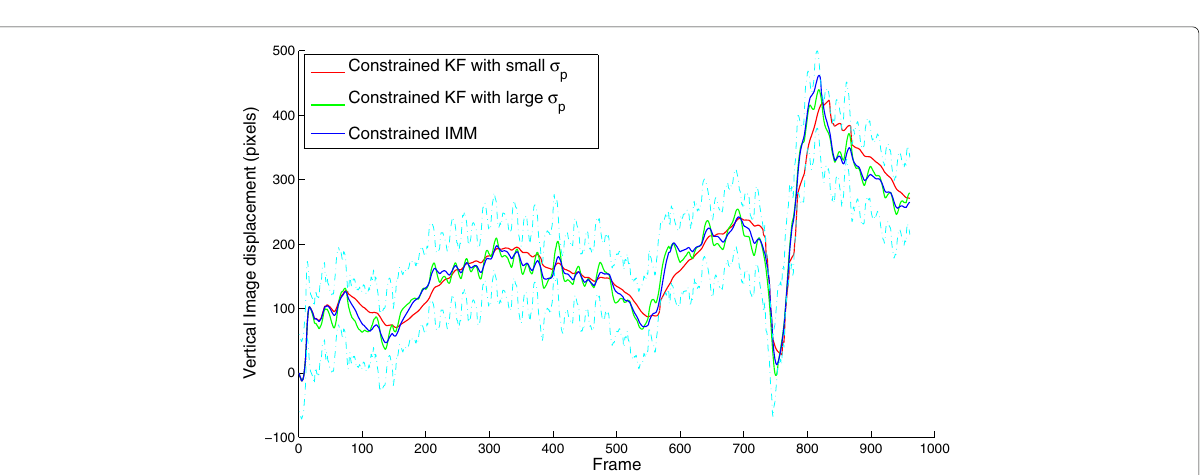
Fig. 9 Video 1 vertical motion: comparison between single-model constrained Kalman filtering and constrained IMM. Cyancurves are constraint